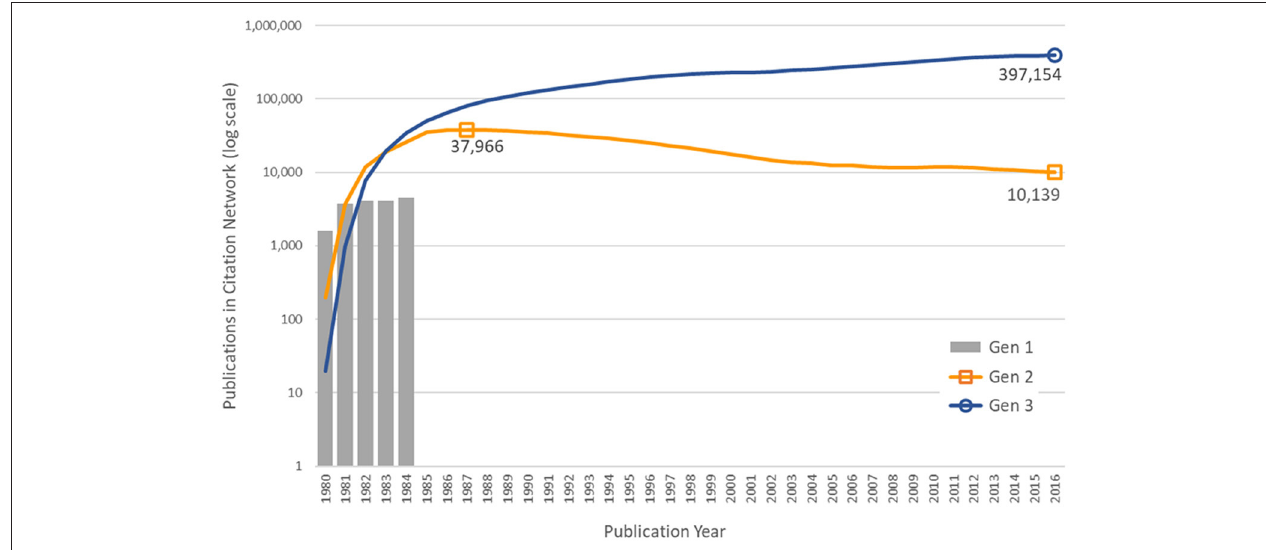
FIGURE 3 | Number of publications in the citation network, by generation and year of publication.